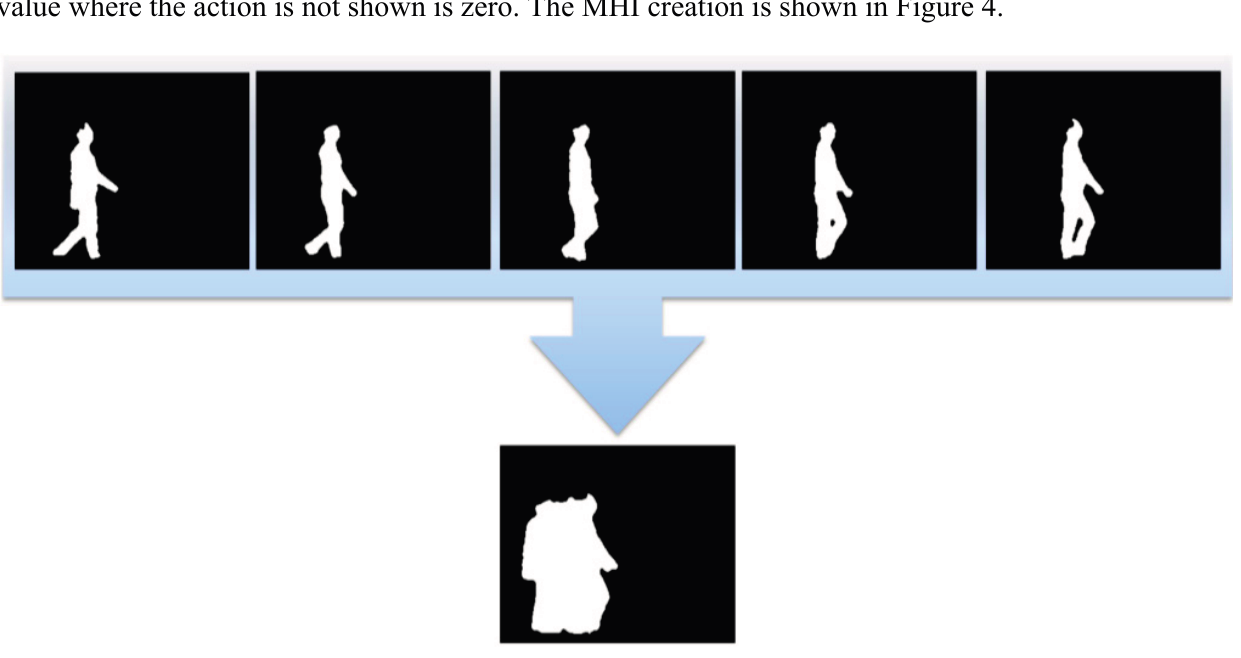
Figure 4. MHI creation processes for walking